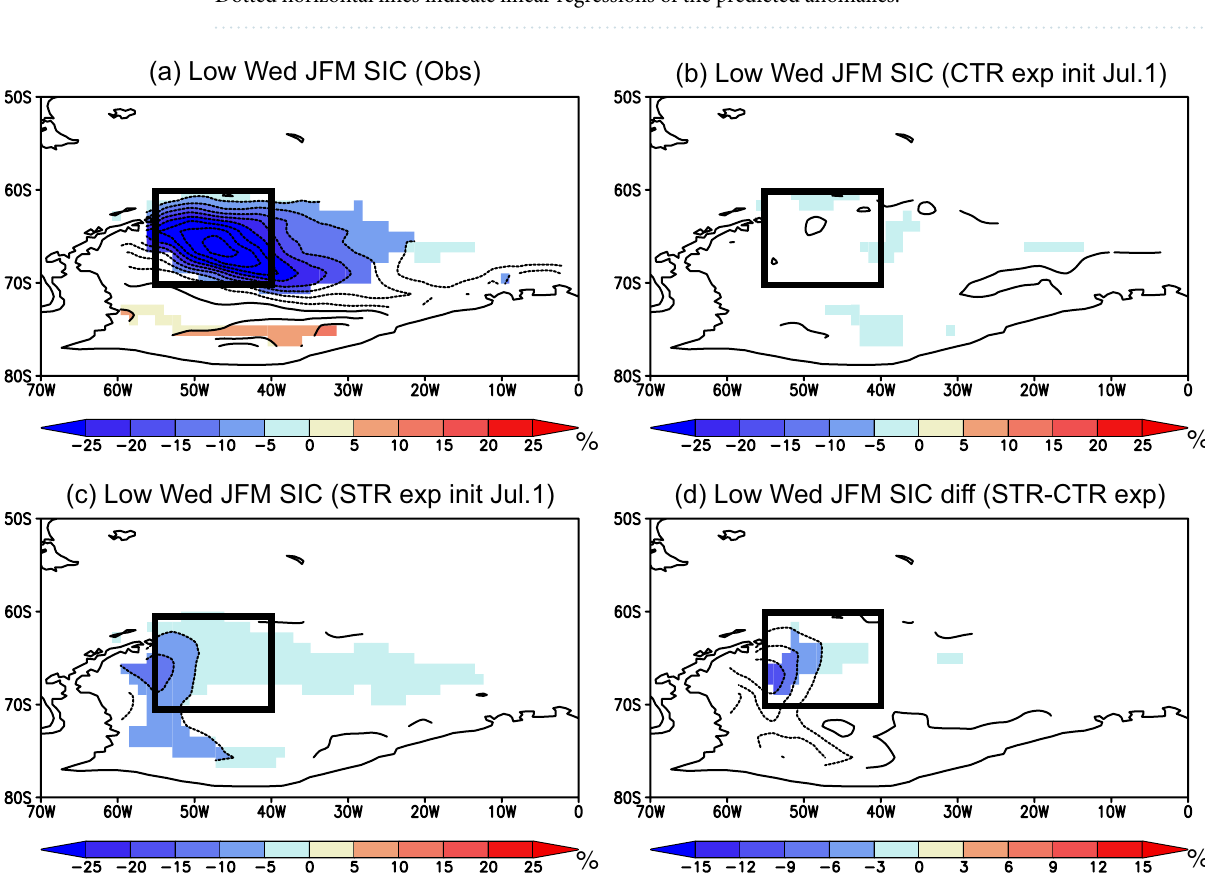
Figure 6. ( a ) Composite SIC anomalies (in %) observed during January–March of low sea-ice years in the Weddell Sea. Colors indicate anomalies that are statistically significant at 98% confidence level using the two- tailed Student’s t -test. A black box corresponds to the region of research interest (70° S–60° S, 55° W–40° W). ( b ) Same as in ( a ), but for the anomalies predicted from July 1st in the CTR experiment. ( c ) Same as in ( b ), but for the anomalies predicted from July 1st in the STR experiment. ( d ) Differences in the composite anomalies between the STR and CTR experiments, i.e., ( c )–( b